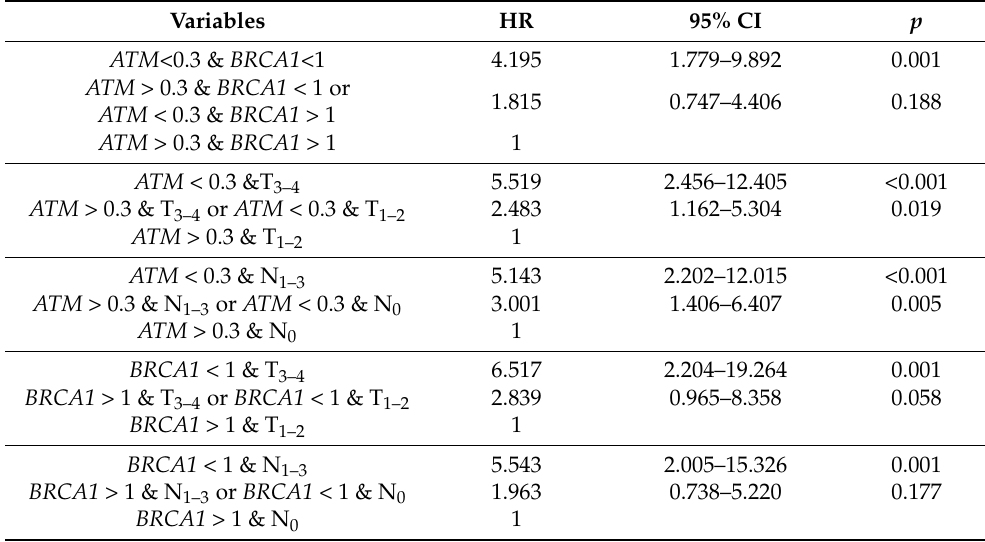
Figure 4. Kaplan-Meier analysis of overall survival (OS) with the combination of two prognosis factors. ( A , B ) OS curves for the combination of ATM and BRCA1 in ( A ) the KMUH cohort ( n for both high: 26, both low: 31, others: 43) and in ( B ) TCGA cohort (atypical and classic molecular subtypes, n for both high: 41, both low: 23). ( C , D ) OS curves for the combination of ATM and ( C ) tumor size ( n for ATM > 0.3 and T 1–2 : 41, ATM < 0.3 and T 3–4 : 20, others: 39) or ( D ) lymph node involvement ( n for ATM > 0.3 and N 0 : 43, ATM < 0.3 and N 1–3 : 17, others: 40) in the KMUH cohort. ( E , F ) OS curves for the combination of BRCA1 and ( E ) tumor size ( n for BRCA1 > 1 and T 1–2 : 19, BRCA1 < 1 and T 3–4 : 29, others: 52) or ( F ) lymph node involvement ( n for BRCA1 > 1 and N 0 : 18, BRCA1 < 1 and N 1–3 : 23, others: 59) in the KMUH cohort. Table 5. Multivariate Cox model analysis of overall survival with combined parameters a